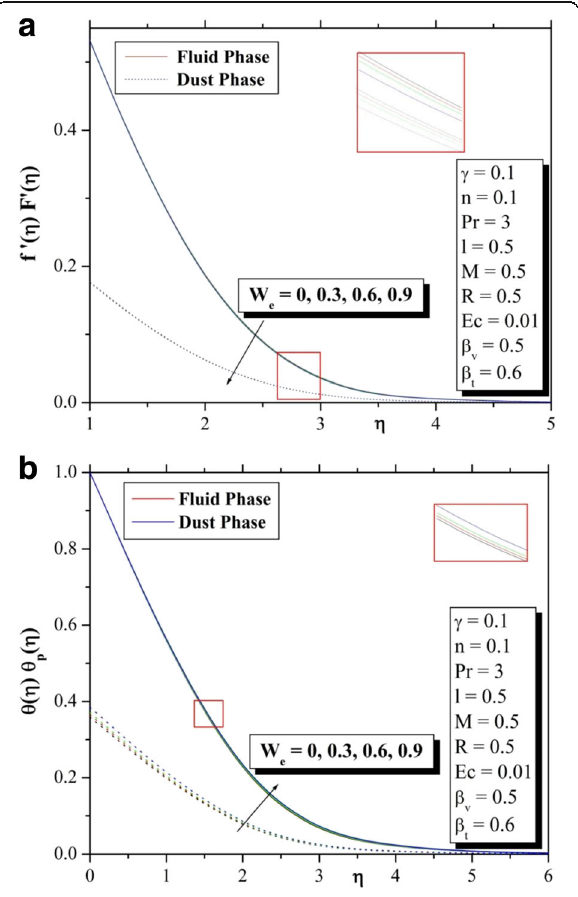
Fig. 2 a , b Velocity profile and temperature profile for different values of W e